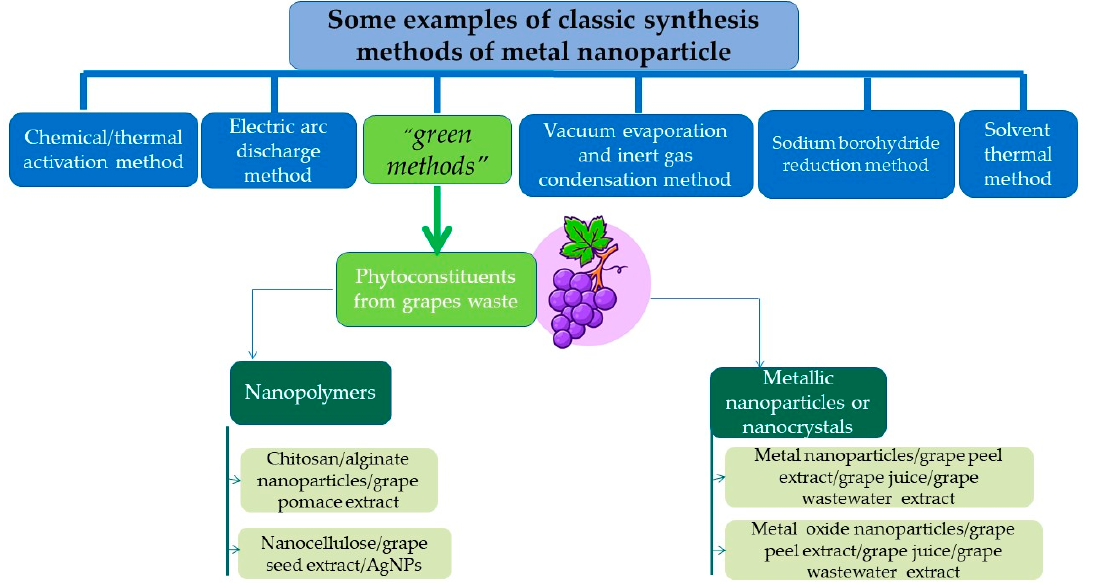
Figure 4. Methods of preparation of different nanomaterials, including examples of grape waste use. (Designed by Brgfx/Freepik).